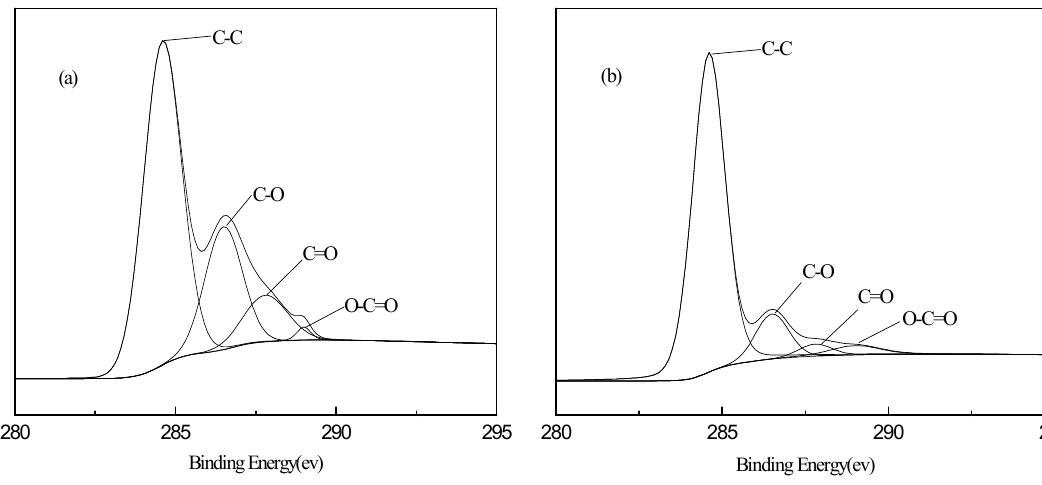
Figure 6. The XPS spectra of ( a ) graphite oxide and ( b ) graphene.